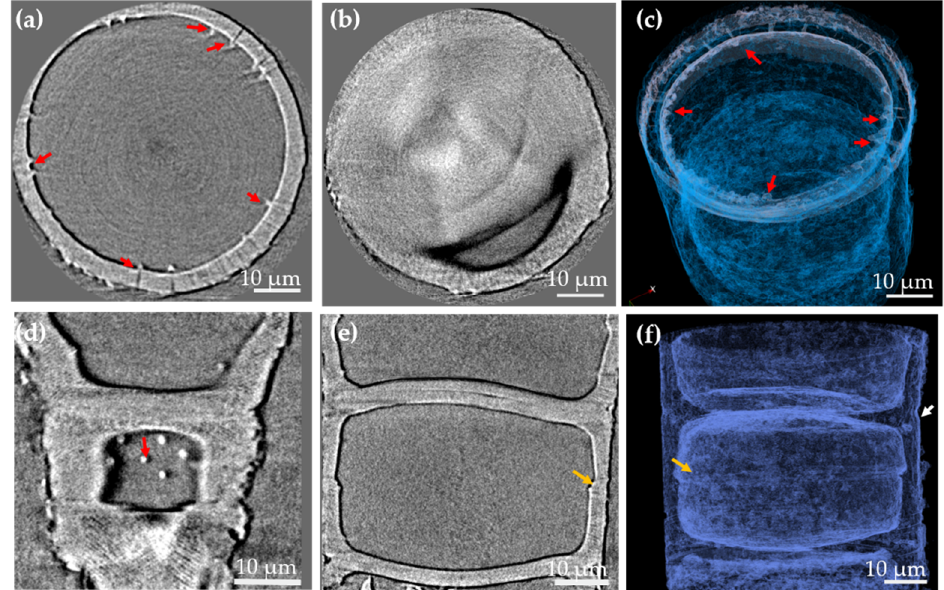
Figure 1. Ellerbeckia frustule studied by nano-XCT. ( a , b ) Valve view of the frustule, ( d , e ) girdle view of the frustule and ( c , f ) 3D rendering of Ellerbeckia in valve view and girdle view, respectively. Red arrows: protrusions, white arrow: pseudosulcus, orange arrows: the region linking the epivalve and hypovalve.